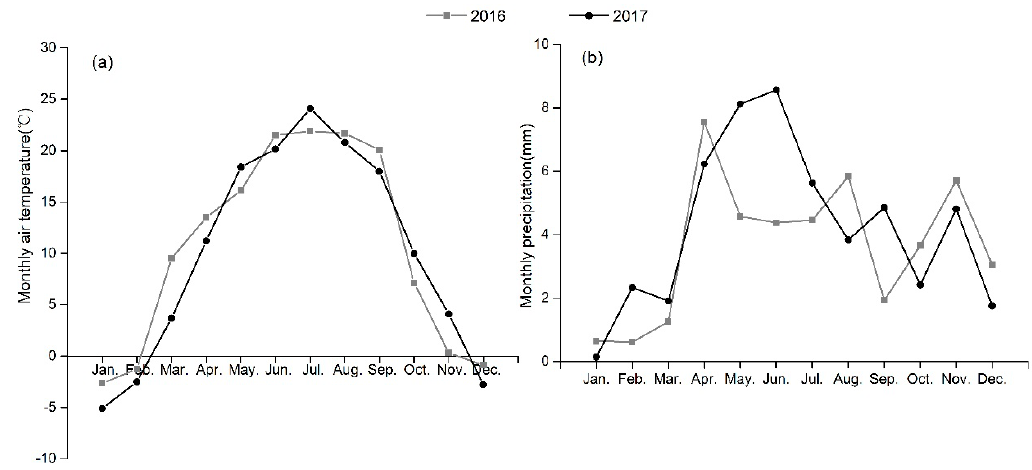
Figure 2. Monthly air temperature ( a ) and precipitation ( b ) in 2016 and 2017 in Xinyuan county of Yili River Valley in Xinjiang Uyghur Autonomous Region, China. Data were recorded in a local meteorological station in Xinyuan County. Table 1. The number of surveyed trees and pooled leaf samples in 2016 and 2017.